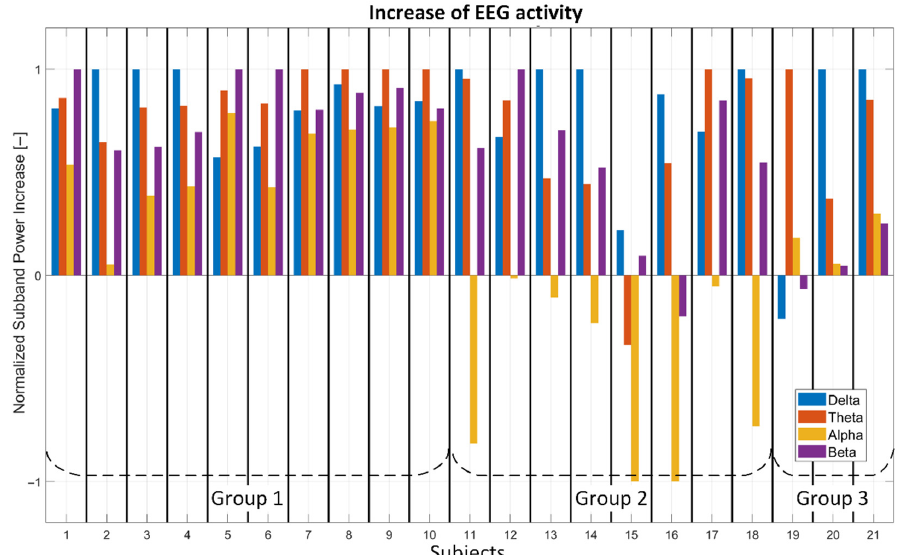
Figure 12. The k-means clustering of the extracted features.